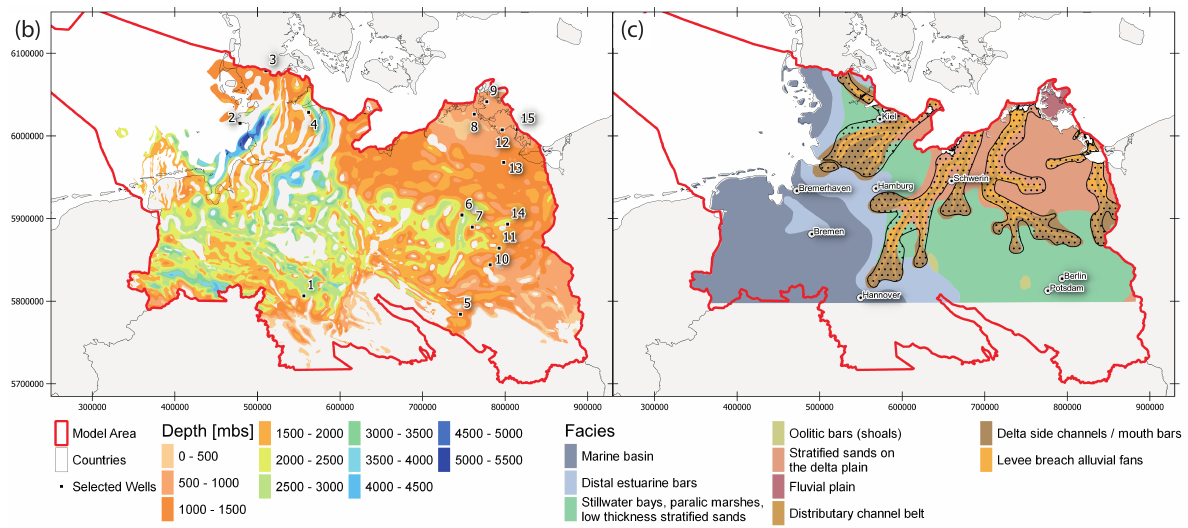
Figure 2. Representation of structural input data: ( a ) Structural model of the area as derived from the TUNB project [31]. Color-coding as indicated on the right: stratigraphic column of the model area with focus on the reservoirs under study and the facies therein. Topography has 50% transparency to allow a view on the deeper layers. Vertical exaggeration = 10 × . The lower right inlay shows the location of the model area in Central Europe. Dark gray = Germany, light gray = other countries. Red outline = model area); ( b ) Elevation distribution of the top of the Upper Keuper unit. Explanation of colors and text below figure, green dots = selected deep wells for sandstone distribution; ( c ) Facies distribution of the Upper Exter Formation [30]. Explanation of colors and text below figure; ( a – c ) Coordinates are in UTM Zone 32N.